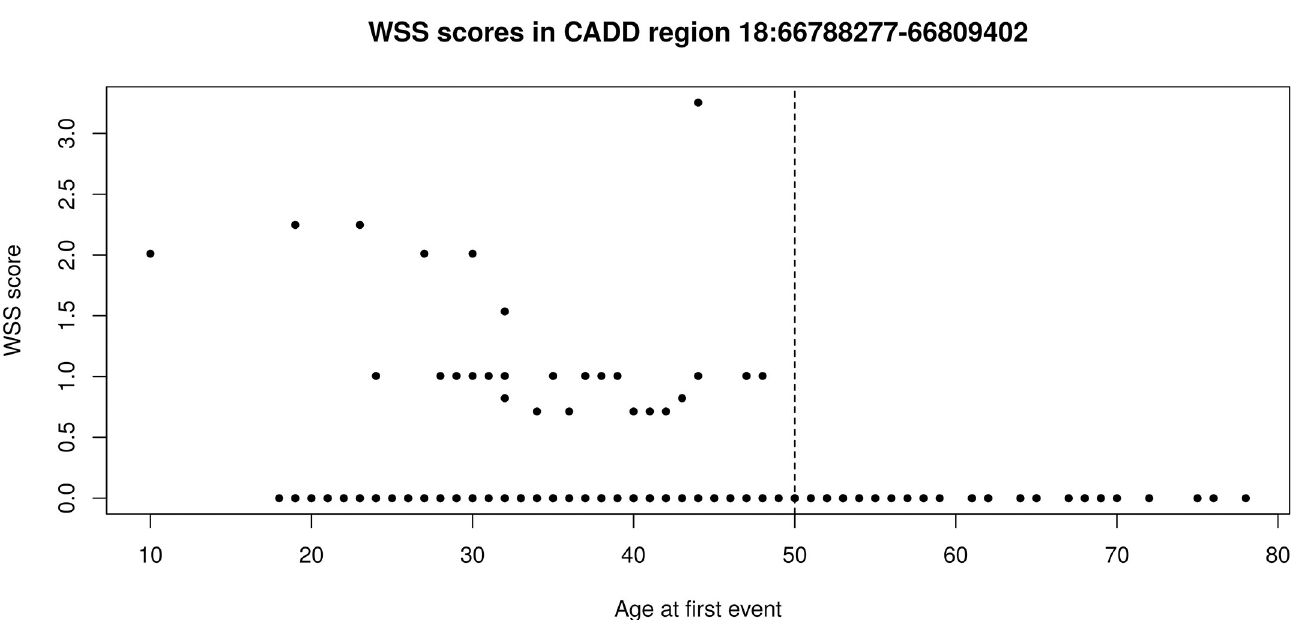
Fig 4. WSS scores in the CADD region depending on the age at first VTE event. The dashed line corresponds to the age 50 discriminating early onset from late onset